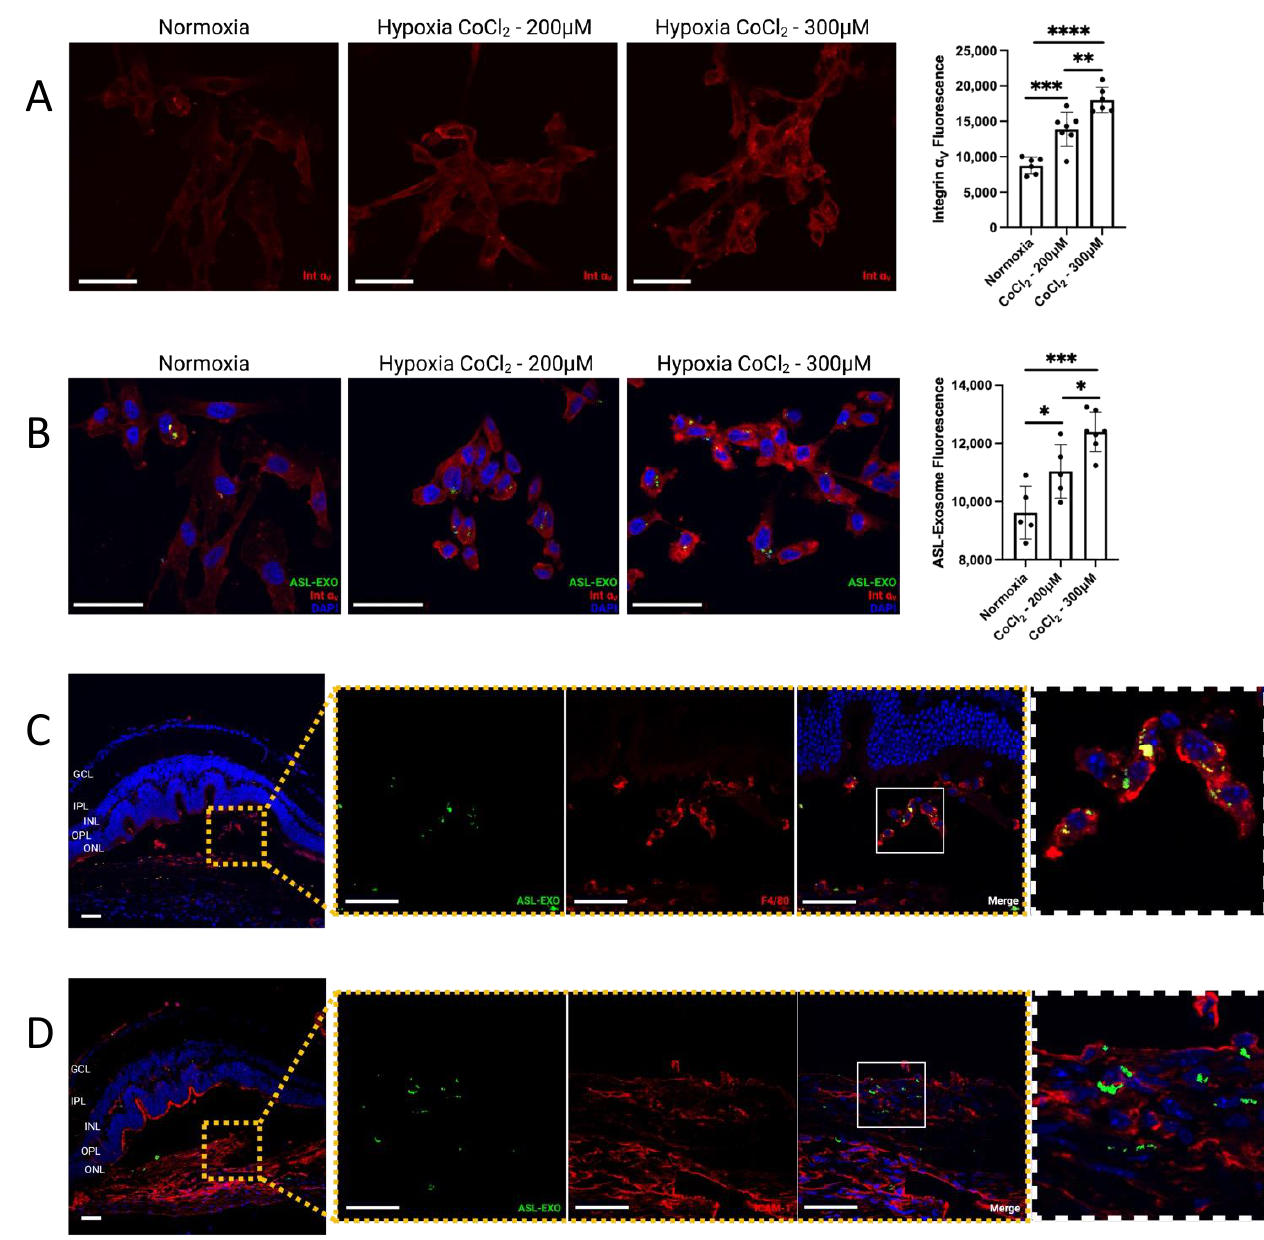
Figure 6. Intracellular uptake of ASL exosomes. Human retinal endothelial cell (HRECs) exposed to hypoxic stress induced by either 200 μM or 300 μM CoCl 2 increased expression of integrin 𝛼 v ( A ) and increased intracellular uptake of ASL exosomes in vitro ( B ) (bar represents mean ± SD, * p < 0.05; ** p < 0.01; *** p < 0.001; **** p < 0.0001). Intravitreal injection of ASL exosomes (1 μL) was given 3 days after laser treatment in a mouse model of CNV and the eyes were harvested 7 days after injection to obtain retinal sections (8 µ m) and RPE/choroid flat-mounts. Representative eye sections showing ASL exosomes (green) internalized by macrophages (F4/80, red) ( C ) and endothelial cells (ICAM-1, red) ( D ), respectively, at the area of CNV in vivo. Scale bar, 50 μm. 3.6. No Reactive Retinal Gliosis after Intravitreal Injection of ASL Exosomes GFAP expression was not increased within the retina after an intravitreal injection of either naïve exosomes (1 day) or ALS-exosomes (7 days), suggesting that intravitreal injection of naïve or ASL-modified exosomes did not induce an immediate reactive retinal gliosis (Figure 7).